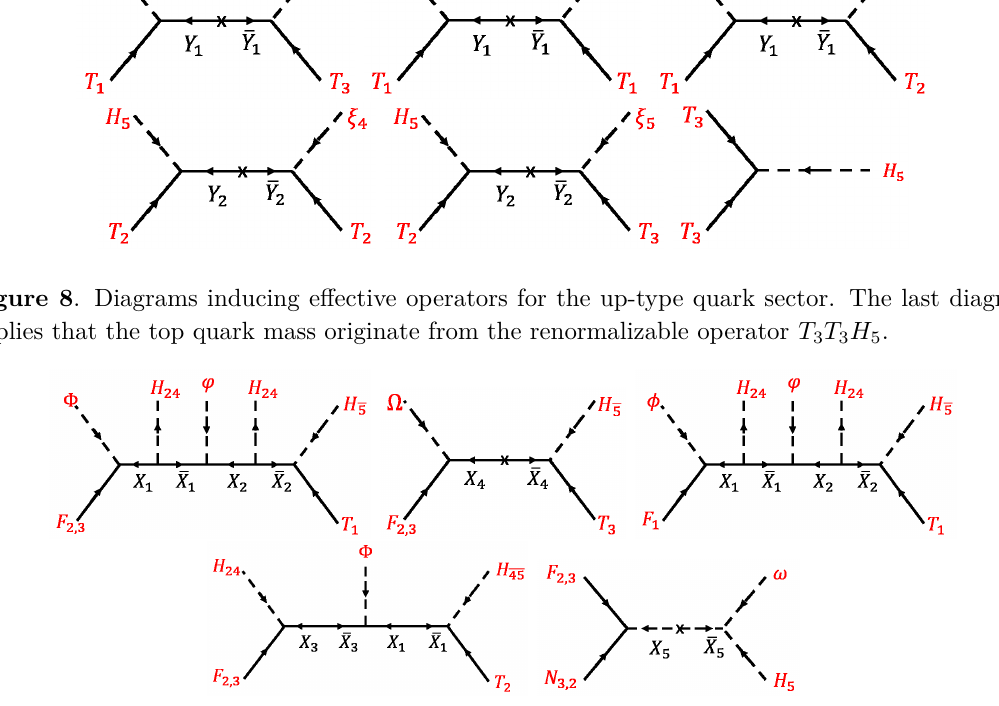
Figure 9 . Diagrams inducing effective operators for the down-type quark and lepton sector. The last diagram is associated to the small Dirac